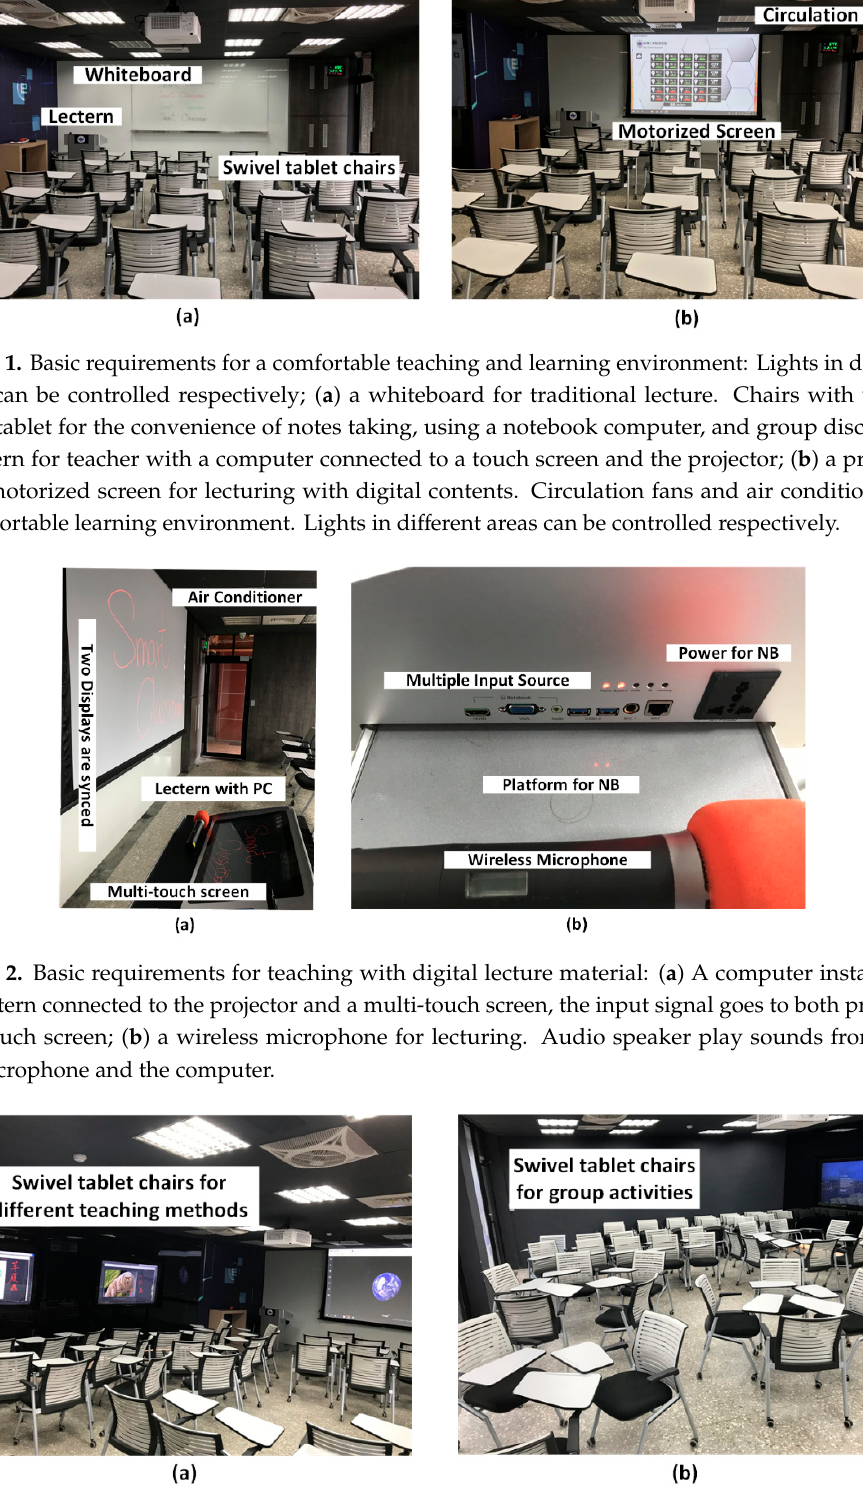
Figure 1. Basic requirements for a comfortable teaching and learning environment: Lights in different areas can be controlled respectively; ( a ) a whiteboard for traditional lecture. Chairs with wheels and a tablet for the convenience of notes taking, using a notebook computer, and group discussion, A lectern for teacher with a computer connected to a touch screen and the projector; ( b ) a projector with motorized screen for lecturing with digital contents. Circulation fans and air conditioner for a comfortable learning environment. Lights in different areas can be controlled respectively.